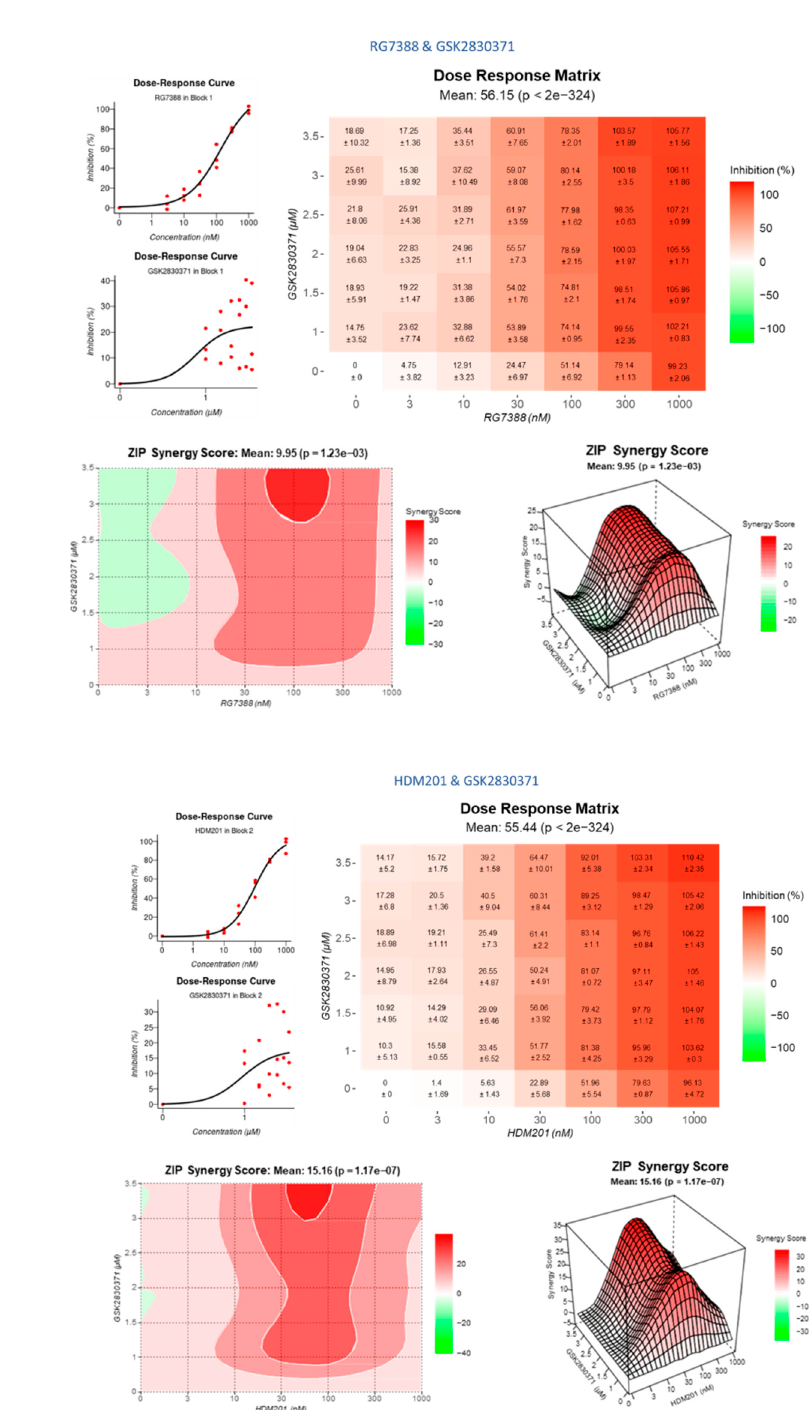
Figure 5. Synergy plots for MDM2/WIP1 inhibitor combination. A dose–response matrix design was used to assess synergy and determine doses at which the greatest synergy was observed, as deter- mined by the Zero Interaction Potency (ZIP) Model. MES-SA cells were treated with either RG7388 or HDM201 and 2.5 µM GSK2830371 for 72 h then growth inhibition was assessed using SRB assay. Dose–response curves, dose–response matrix and synergy plots for RG7388 and GSK2830371, ( A ) and ( B ), and for HDM201 and GSK2830371, ( C ) and ( D ). Statistical significance was evaluated using a paired t -test, ** = p ≤ 0.01.